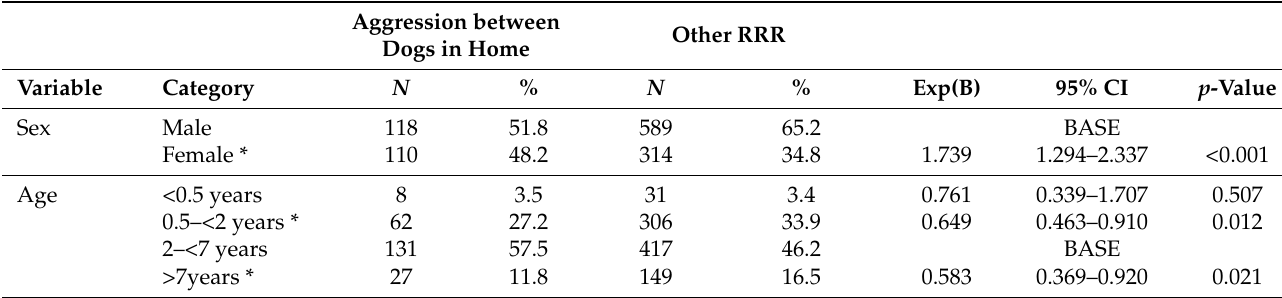
Table 5. Descriptive statistics and multivariate logistic model for dog characteristic variables associated with request for relinquishment due to aggression between dogs in the home among dogs presented for relinquishment due to behavioural